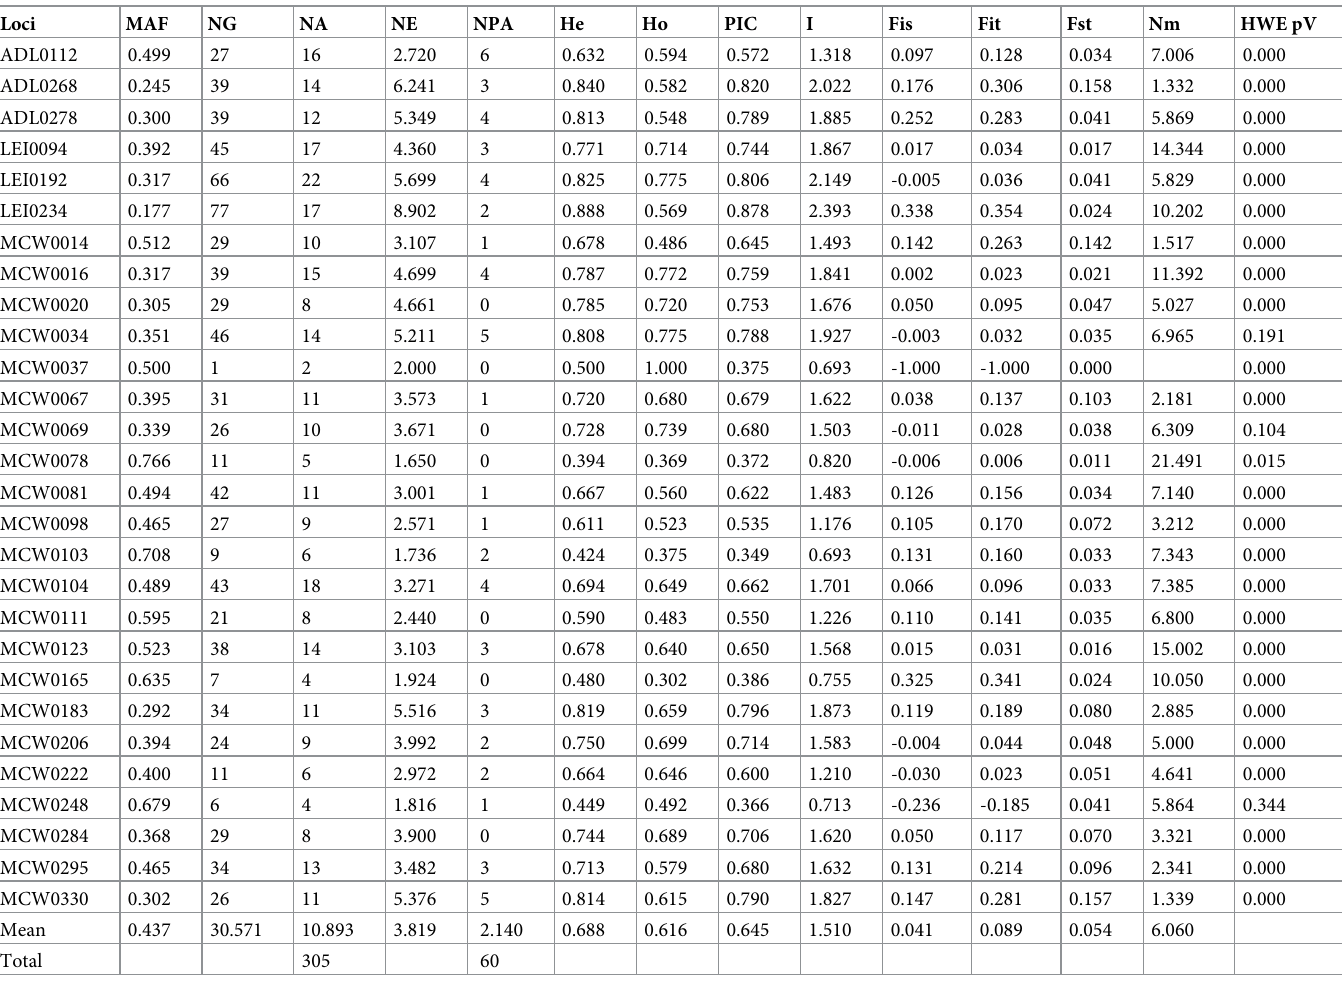
Table 2. Marker polymorphism and diversity parameters across studied IC populations in